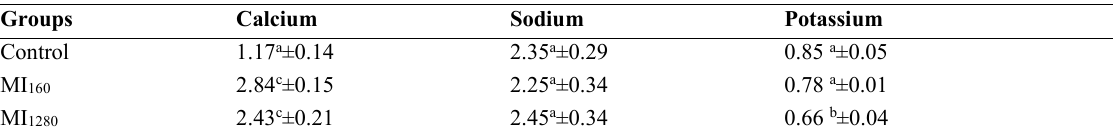
Table 6. Mean Total intracellular calcium (mg/dl), Na+ (μg/dl), and K + (μg/dl) levels in BMSCs after 36 hours of treatment with